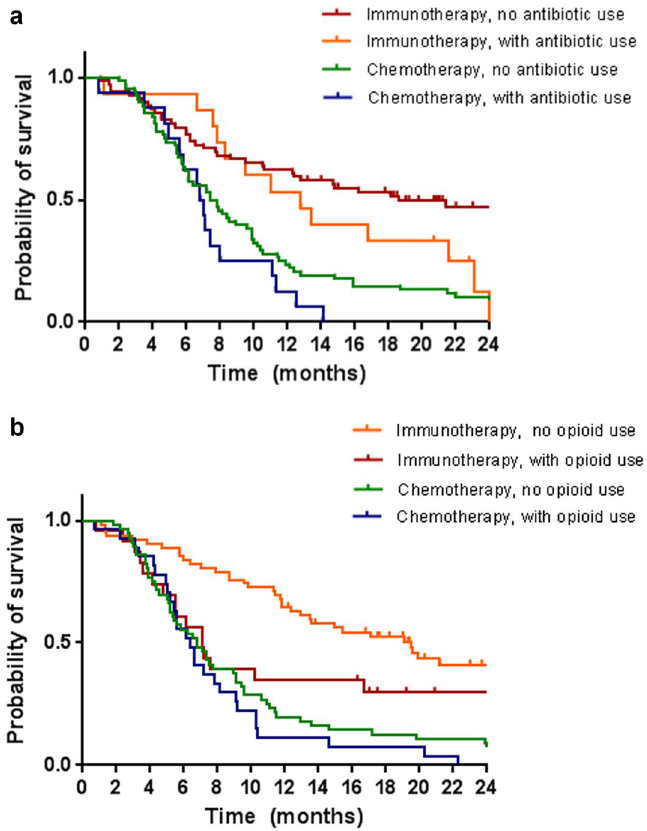
Figure 1. Kaplan–Meier curves showing overall survival for first-line chemo- and immunotherapy with and without the use of antibiotics ( a ) and with and without the use of opioids ( b